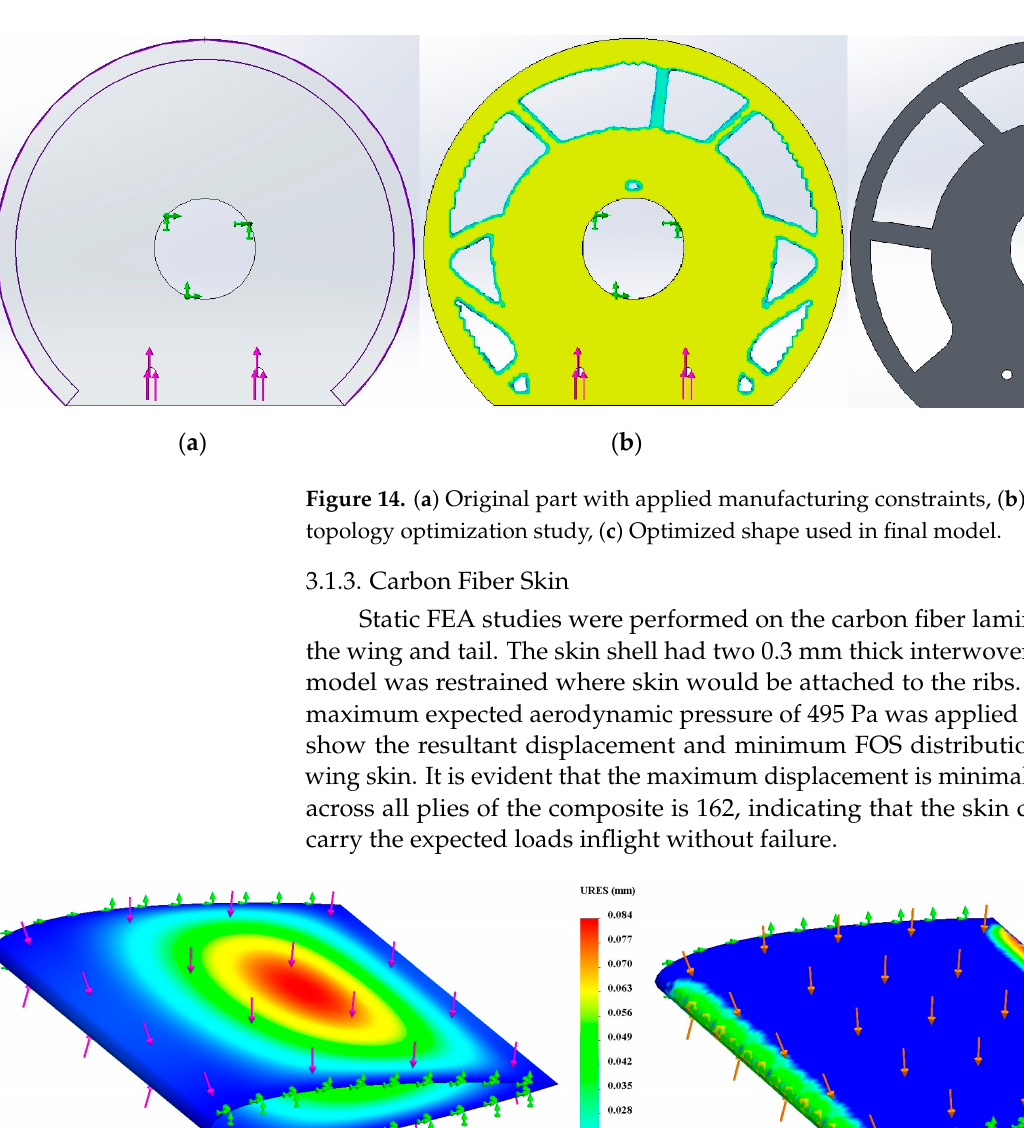
( b ) Figure 13. ( a ) Displacement of main landing gear in static study; ( b ) Main landing gear’s 1st ( left , 70 Hz) and 2nd ( right , 170 Hz) NRB mode shapes . Modal analysis of the frame was also conducted for two reasons: first, to ensure that the anticipated excitation frequency during take-off and landing, which was estimated to be between 20 and 30 Hz, is far from the first natural frequency to avoid resonance, and second, to check if the first significant mode shape results in any twisting of the frame, that would require several plies to have a 45° fiber-orientation angle. A conservative ap- proach was taken in the modal analysis by defining no fixtures. The first non-rigid body (NRB) mode was a bending mode, as shown in Figure 13b, and occurred at a frequency of 70 Hz. The second NRB mode was a twisting mode, also shown in Figure 13b, and oc- curred at around 170 Hz. Hence, no plies with a 45° fiber-orientation angle were intro- duced to the composite laminate of the main landing gear frame since resonance is un- likely to happen at the frequency of this twisting vibration mode. 3.1.2. Bulkheads The main and front bulkhead designs were refined using topology optimization studies in SolidWorks Simulation (version 2020). The goal was to reduce the weight by 30% while maximizing the stiffness-to-weight ratio. In each study, manufacturing con- straints were applied such that critical areas of the parts were preserved. Figure 14a shows the outer ring, outlined in purple, representing the preserved area needed to contour the